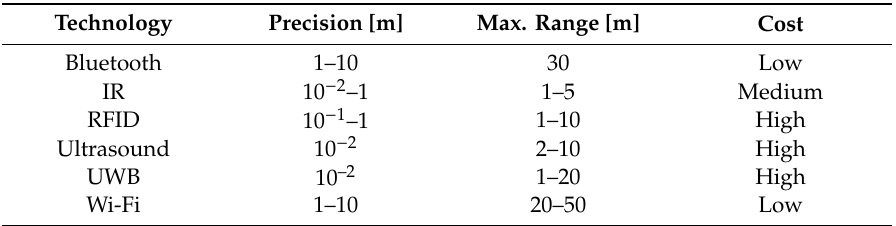
Table 1. Comparison between typical localization